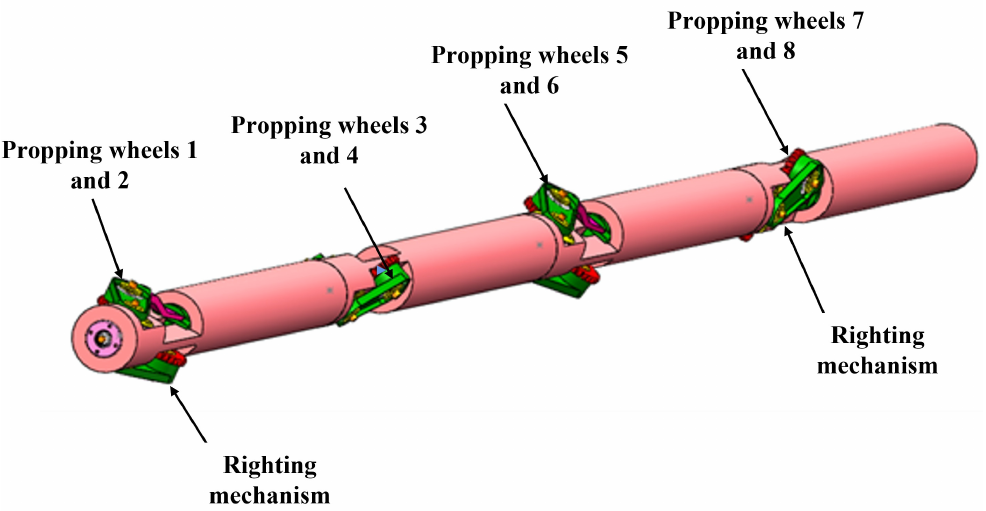
Figure 5. Three − dimensional model of wheeled downhole tractor.